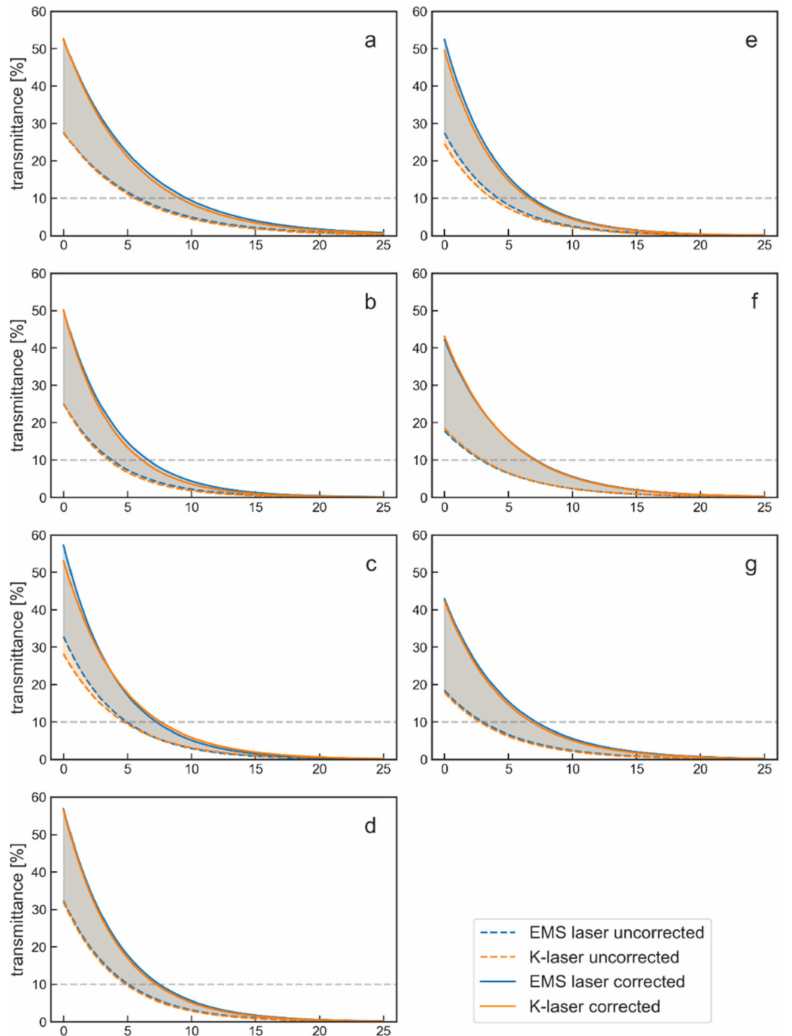
Figure 5. Transmittance curves before and after correction for different tissues (( a ), chicken muscle; ( b ), porcine muscle; ( c ), beef muscle 1; ( d ), beef muscle 2; ( e ), porcine skin; ( f ), beef fat; ( g ), beef tendon). The transmittance in percent is plotted against the tissue thickness in millimeters. While the uncorrected curves are the same as in Figure 4, the corrected curves were added here as solid lines. The areas between the uncorrected and corrected curves are filled with the according color of the laser therapy device. This area gives the range of what are most likely the true transmittance values. Dotted gray lines represent the 10% penetration